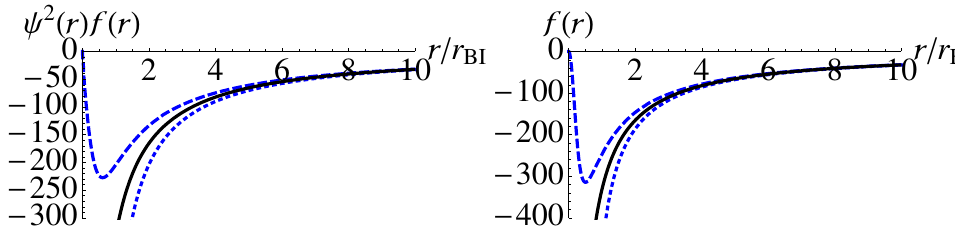
Figure 3. The numerical results of the metric functions ψ 2 ( r ) f ( r ) ( left ) and f ( r ) ( right ) are shown as √ κ . The dashed, dotted and the solid curves correspond to δ = 0.01, functions of r / r BI , where r BI ≡ δ = − 0.01 and δ = 0 (GR) at x i = 10,